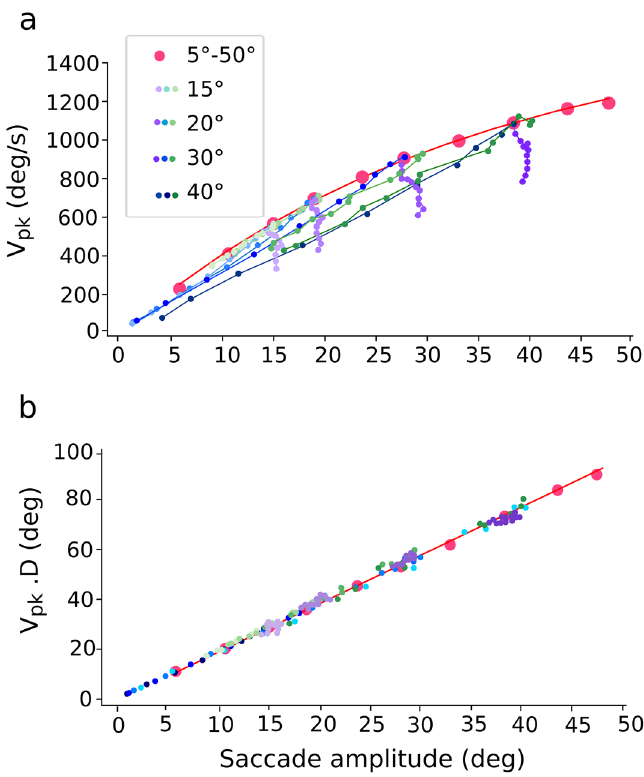
Figure 9. Nonlinear main-sequence behavior of the model. ( a ) Red dots: Saturating amplitude-peak eye velocity relation (Eq. (5)) for the default input current (σ pop = 0.5 mm; β = 0.03; I 0 = 3.0 pA) applied at 10 different sites. Blue dots: peak eye velocity of saccades evoked at sites T = 15, 20, 30 and 40 deg, respectively, for input currents with different input population sizes (from 0.05 to 1.0 mm), and fixed β. Purple dots: peak eye velocity of saccades evoked at the same sites, for input currents (σ pop = 0.5 mm) with changing (β, I 0 ), which kept the number of SC spikes constant. Green dots: same, for input currents with changing (β, I 0 ), keeping the number of input-layer spikes constant (compare with Fig. 1a). ( b ) The model saccades all follow the strict linear relationship (Eq. 6) for all stimulation conditions, and for all fast and slow saccades of ( a